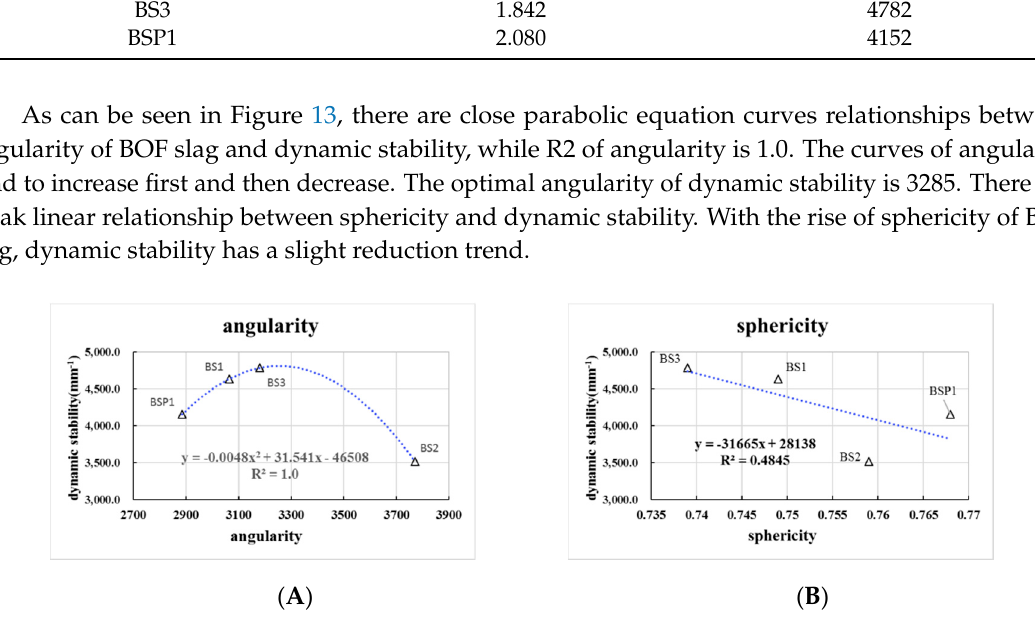
Table 13. Rutting text results with different coarse aggregates.